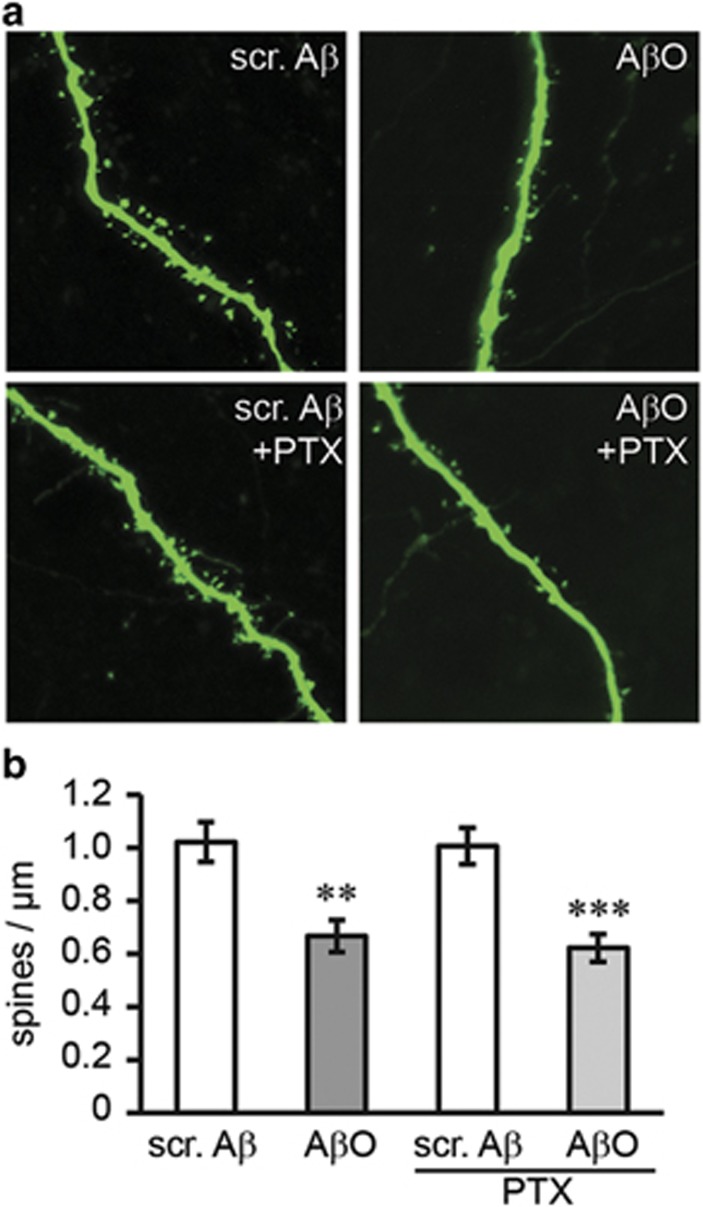
Oligomeric Aβ-induced synaptic loss is not prevented by treatment with PTX. (a) Confocal images of dendrites from CA1 neurons in the stratum radiatum of non-transgenic slice cultures treated with oligomeric Aβ (500 nM) or scrambled Aβ (500 nM) and G protein inhibitor PTX (500 ng/ml). (b) PTX treatment does not prevent Aβ oligomer-induced dendritic spine loss. n=12. Values are shown as mean±S.E.M. (**P<0.01, ***P<0.001; two-tailed unpaired Student's t-test). Scr. Aβ, scrambled Aβ; AβO, oligomeric Aβ; PTX, pertussis toxin